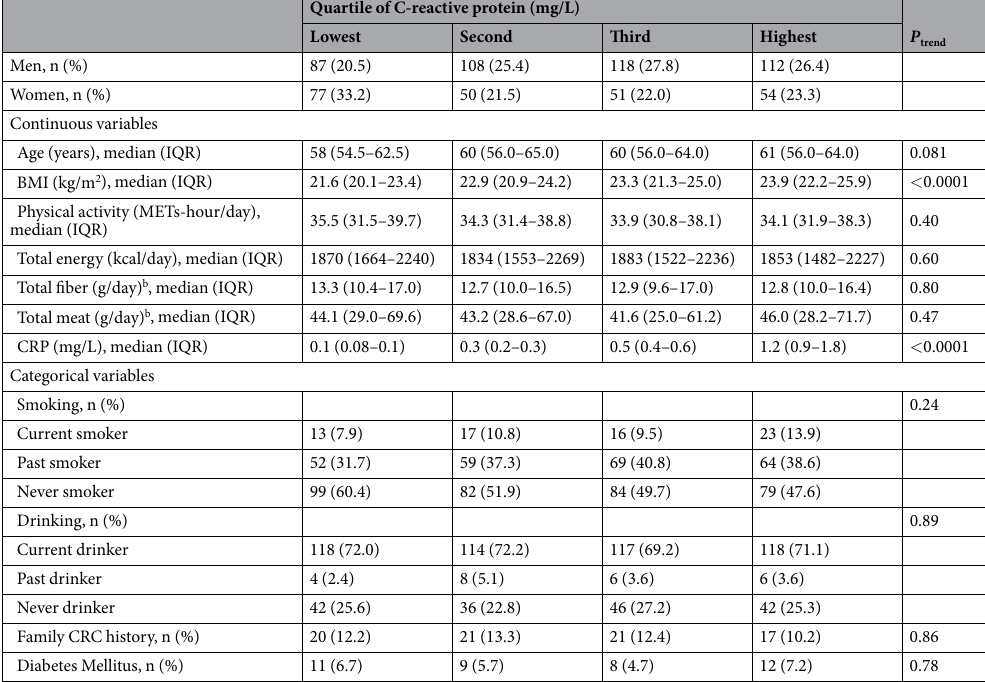
Table 2. Selected characteristics of controls according to C-reactive protein level. a n, number of subjects; BMI, body mass index; METs, metabolic equivalents; CRC, colorectal cancer; SD, standard deviation; IQR, inter- quartile range. b